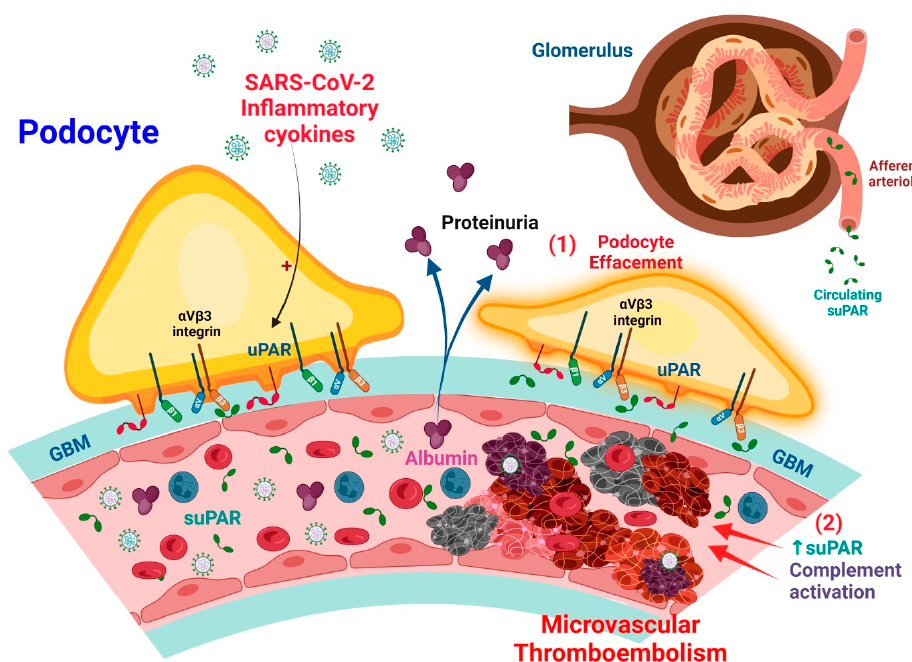
Figure 2. Putative molecular mechanism of suPAR-related podocyte injury and glomerular capillary microthrombus formation in COVID-19-related AKI. (1) High-level suPAR activation of integrin α v β 3 signaling impairs podocytes. (2) High levels of suPAR in combination with complement activation exacerbate the hypercoagulable state that leads to the development of AKI.